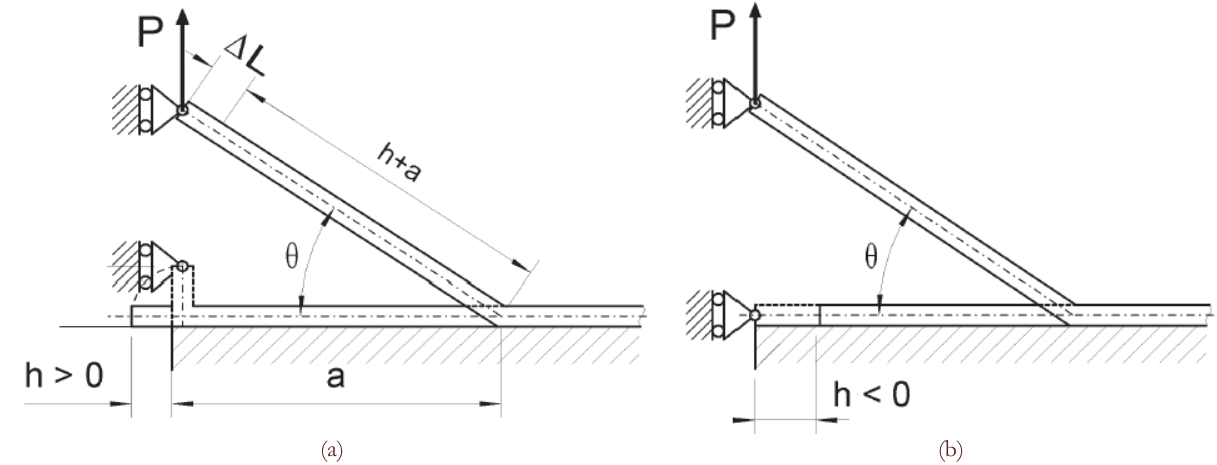
Figure 1: Peeling of a load. Initial configuration (a): a length h of the tape is not attached to the substrate and it is rotated before applying the external force P; initial configuration (b): the tape is stretched of a quantity h before